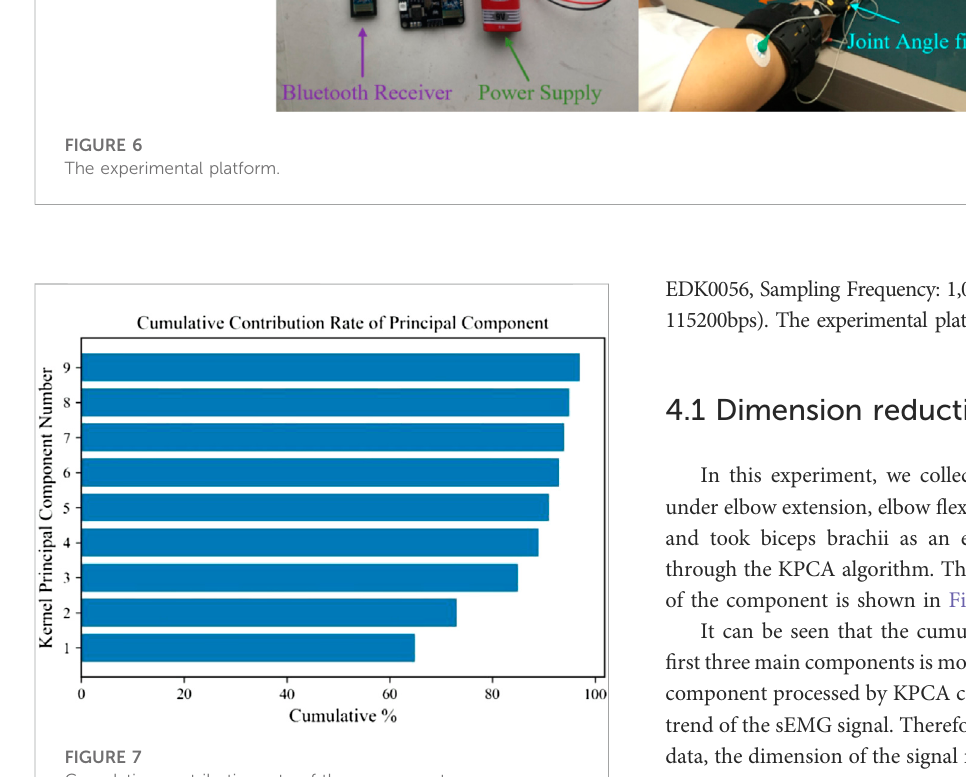
FIGURE 7 Cumulative contribution rate of the